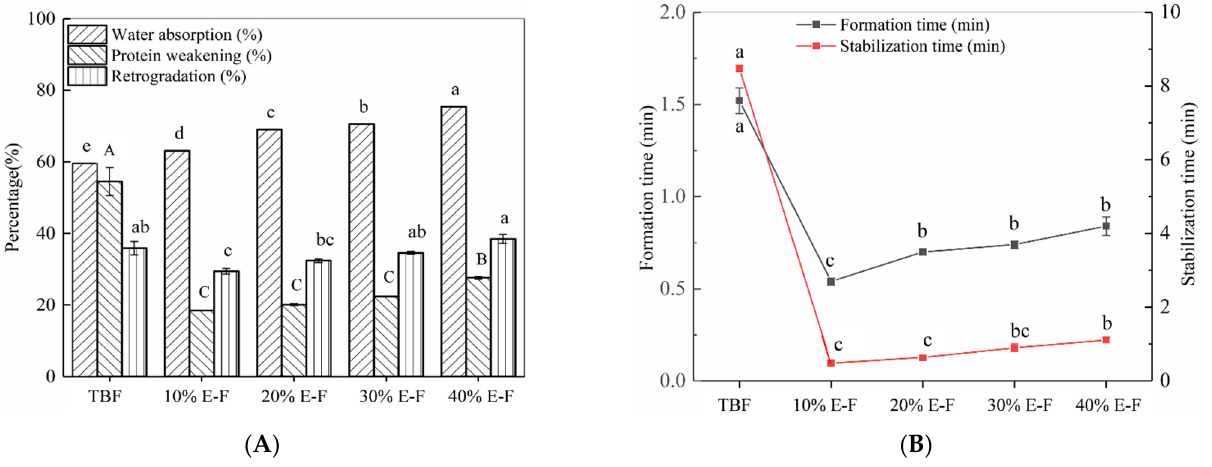
Figure 3. The water absorption rate, protein weakness, and retrogradation rate of dough for Tartary buckwheat flour (TBF) and blended flour ( A ). Dough formation time and stabilization time for Tartary buckwheat flour (TBF) and blended flour ( B ). The 10% E-F, 20% E-F, 30% E-F, and 40% E-F represent that the addition of extruded starch in the blended flour was 10%, 20%, 30%, and 40%, respectively. Different letters (uppercase and lowercase) in the same group represent significant differences ( p < 0.05).